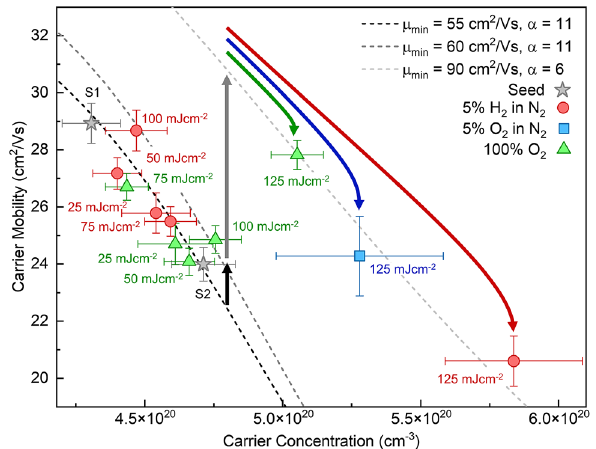
Figure 2. Optoelectronic properties of all seed and laser processed ITO thin films. “Optical” carrier concentration, N opt , and mobility, µ opt , of the seed ITO thin films (grey stars) and those subject to single-pulse ReLA at 25 − 125 mJcm − 2 in 5% H 2 in N 2 (red circles) and 100% O 2 (green triangles). We also present the sample processed with 125 mJcm − 2 in 5% O 2 in N 2 with the blue square. The dashed lines indicate the theoretical trend of µ ( N ) considering various scattering mechanisms. The parameters of µ ( N ) that are related to ionised cluster scattering ( µ min and α ) were fitted to the seed materials and those subject to ReLA at below 100 mJcm − 2 (black dashed line), at 100 mJcm − 2 (dark grey dashed line) and at 125 mJcm − 2 (light grey dashed line). The black and grey arrows indicate the mobility-only transition to the next cluster and the red, blue, and green arrows indicate the ambient dependent transition to higher N opt after ReLA at 125 mJcm − 2 in 5% H 2 in N 2 , 5% O 2 in N 2 and 100% O 2 ,